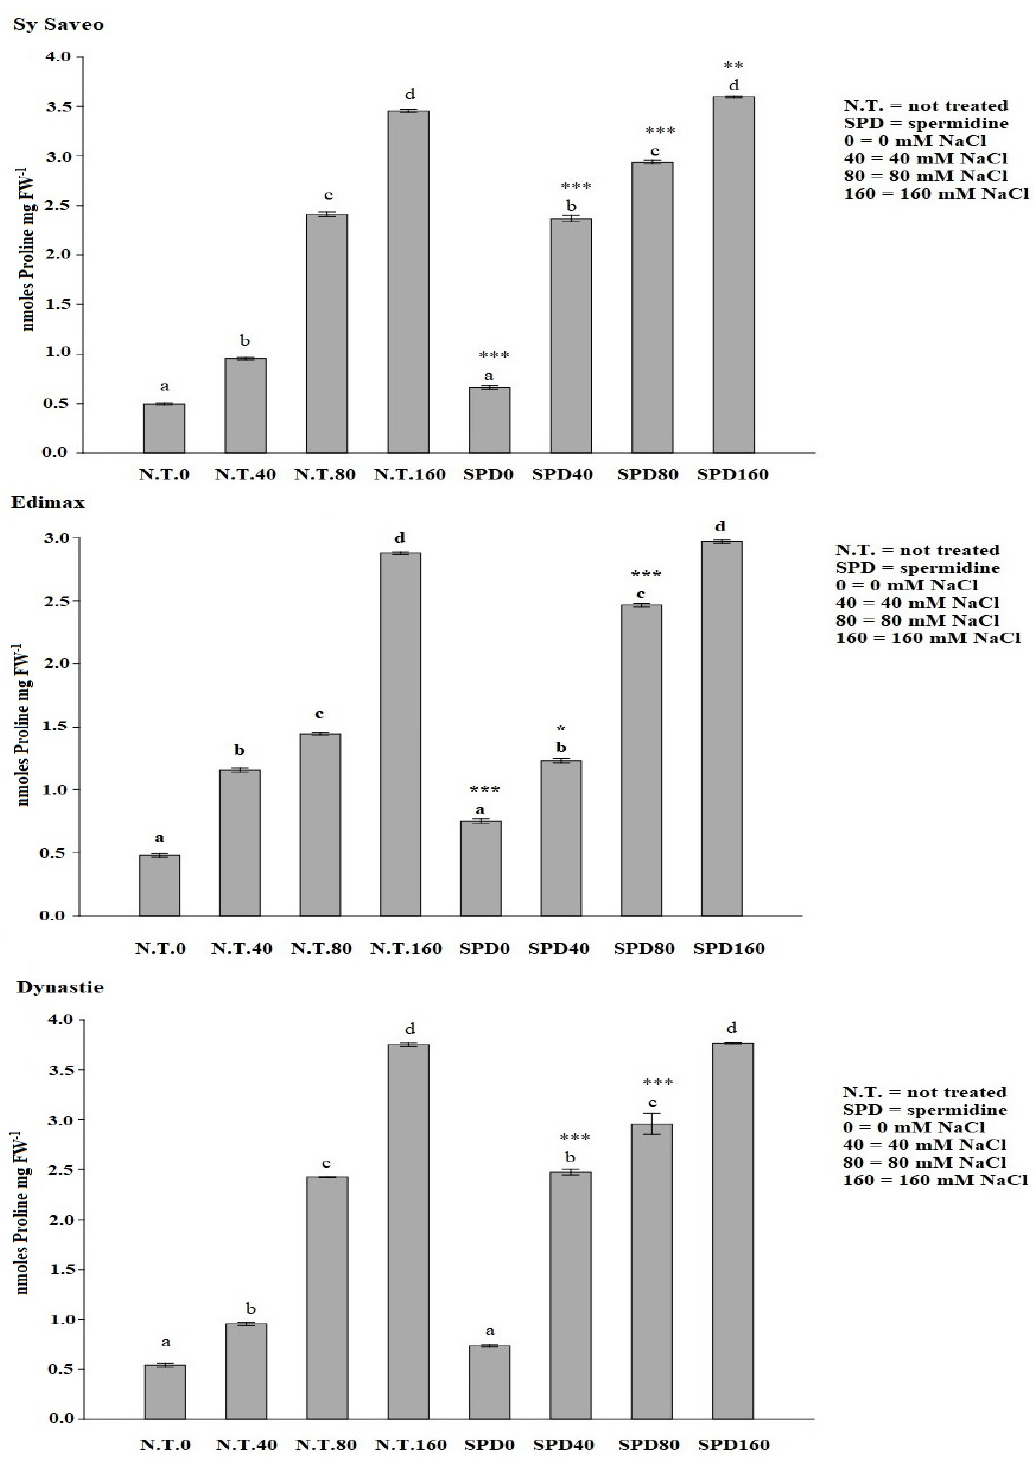
Figure 4. Effect of spermidine priming on proline amount of rapeseed cultivars exposed to saline conditions. Data are expressed as means ± SE ( n = 3). Mean values in the column marked by different letters are significantly different within the same group ( p ≤ 0.05; ANOVA and Tukey–Kramer test). Significant differences between groups are reported as * p < 0.05; ** p < 0.01; *** p < 0.001.